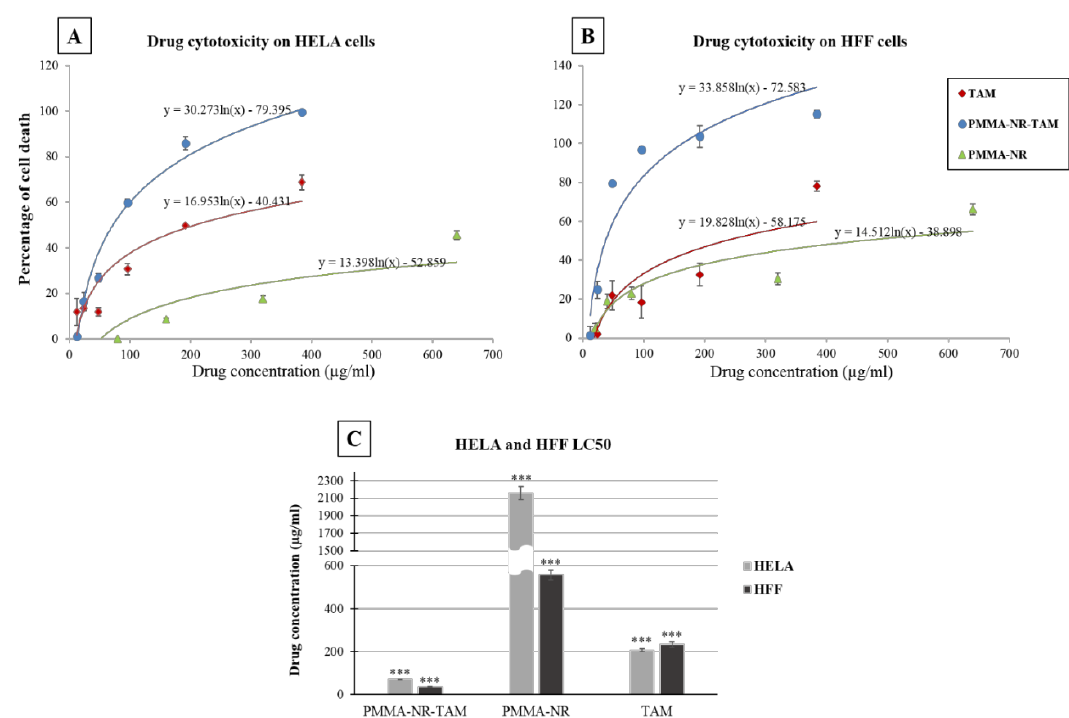
Figure 6. Dose response curves showing the cytotoxic activities of PMMA-NR-Si-TAM, PMMA-NR and free TAM on HELA and HFF-1 cells. ( A ) Logarithmic dose response curve of the HELA cervical cell line. ( B ) Logarithmic dose response curve of normal cell lines HFF-1. ( C ) LC50 of PMMA-NR-Si-TAM, PMMA-NR and free TAM on HELA and HFF-1 cells. The results are presented as average ± standard deviation of three independent measurements (*** p < 0.001, n = 3). Table 2. HELA and HFF-1 treated with PMMA-NR-Si-TAM, PMMA-NR and free TAM.